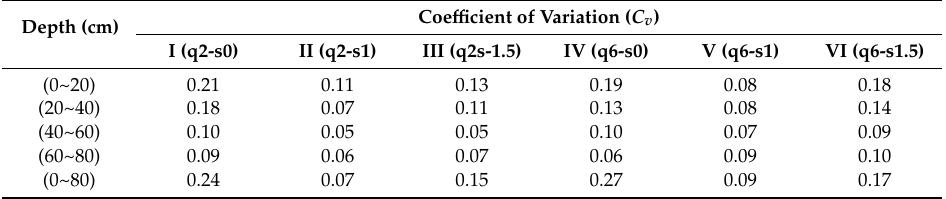
Table 5. Statistical characteristics of the average increment of SO 2 after